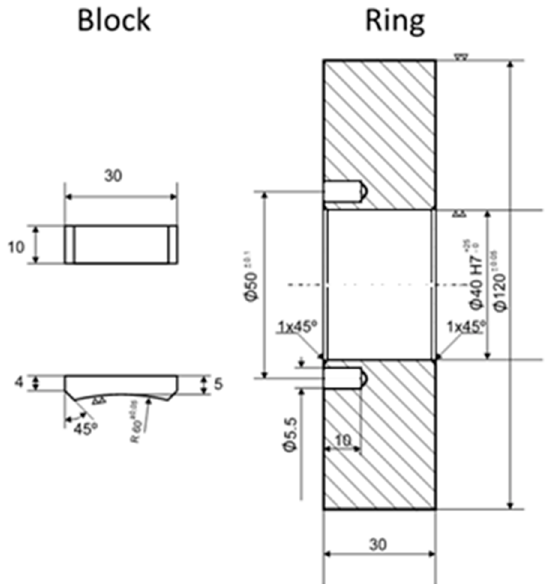
Figure 1. Geometry of blocks and ring used.